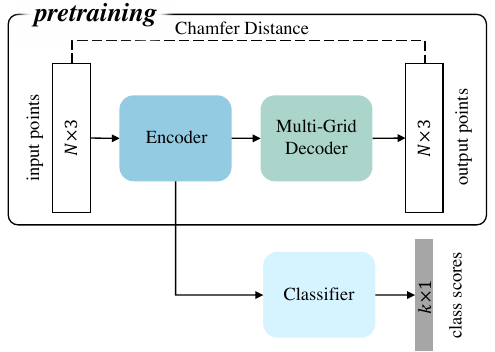
Figure 1. Overall self-supervised model framework. During pretraining, the upper network trains the multigrid autoencoder. When training the classification network, the lower network completes the classifier’s training and fine-tunes the overall classification